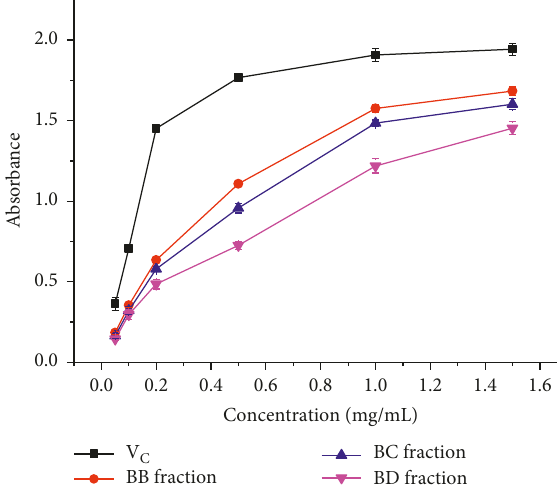
Figure 12: Reducing power of V C , BB, BC, and BD